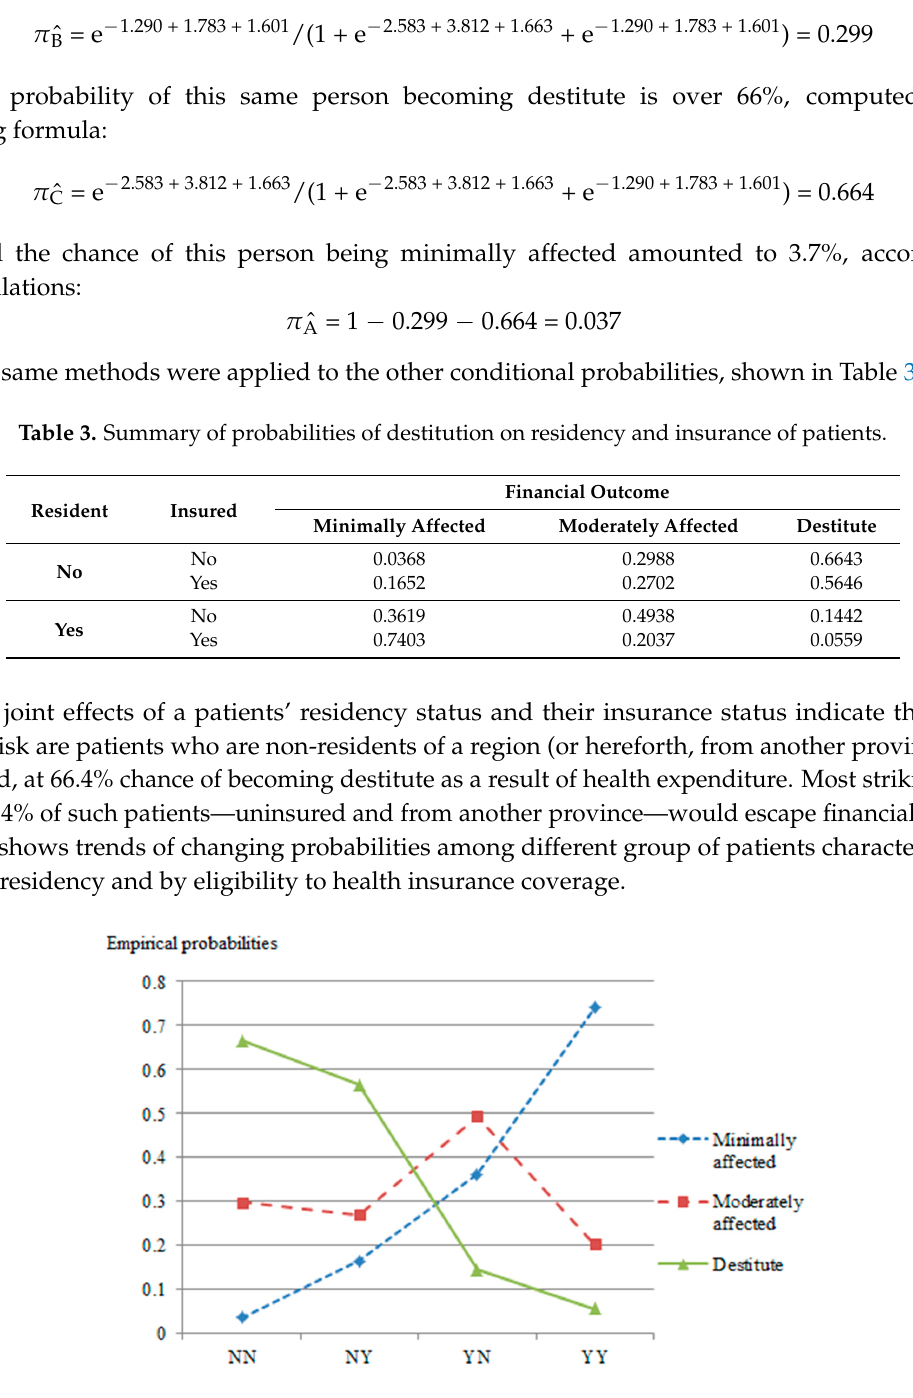
Figure 4. Contrasting financial welfare of patients as a function of status of residency and insurance